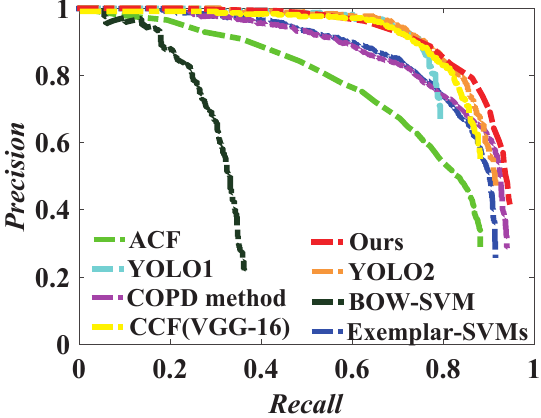
Figure 9. PRC of the eight competitive methods with the satellite